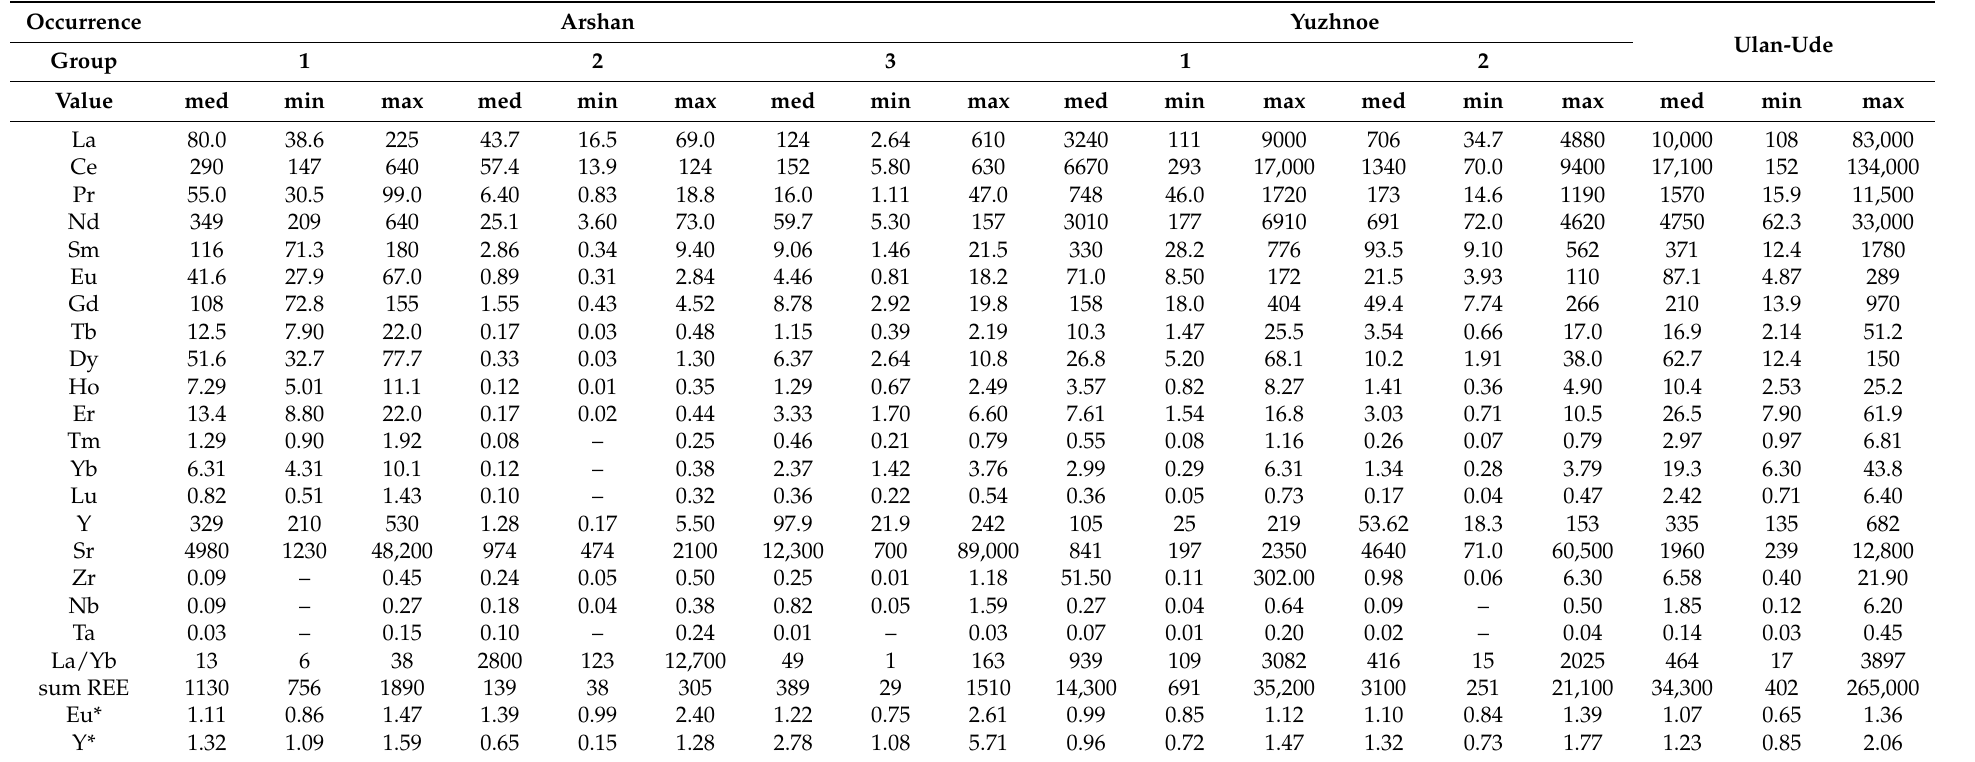
Table 1. Trace element compositions (ppm) of fluorites from Arshan, Yuzhnoe and Ulan-Ude